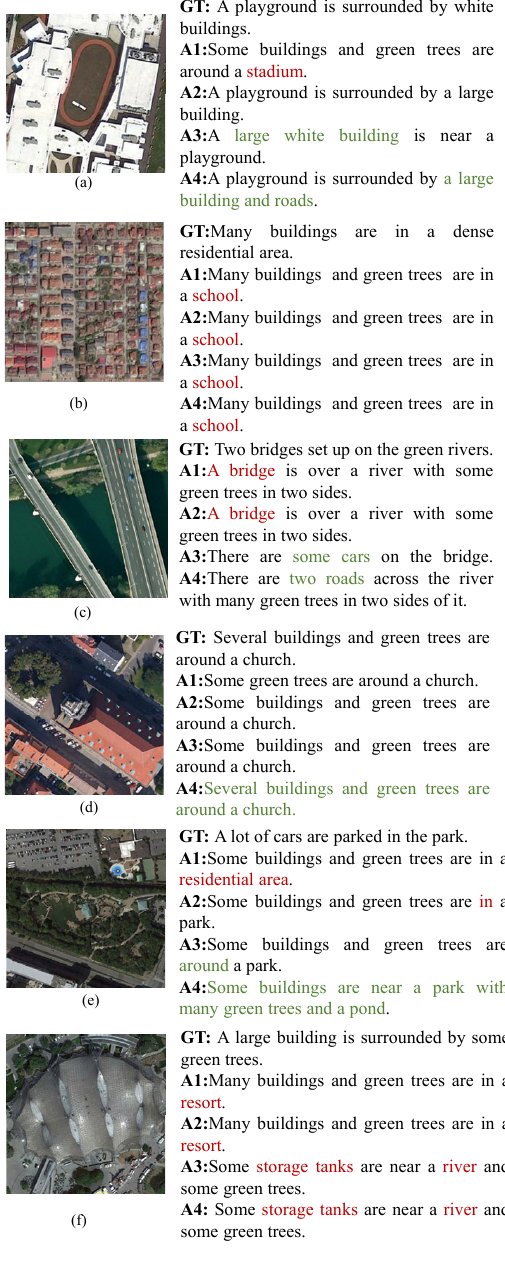
Figure 7. ( a – f ) Some typical examples on the RSICD test set. The GT sentences are human-annotated sentences, while the other sentences are generated by the ablation models. The wrong words generated by all models are indicated with red font; the green font words were generated by the ablation